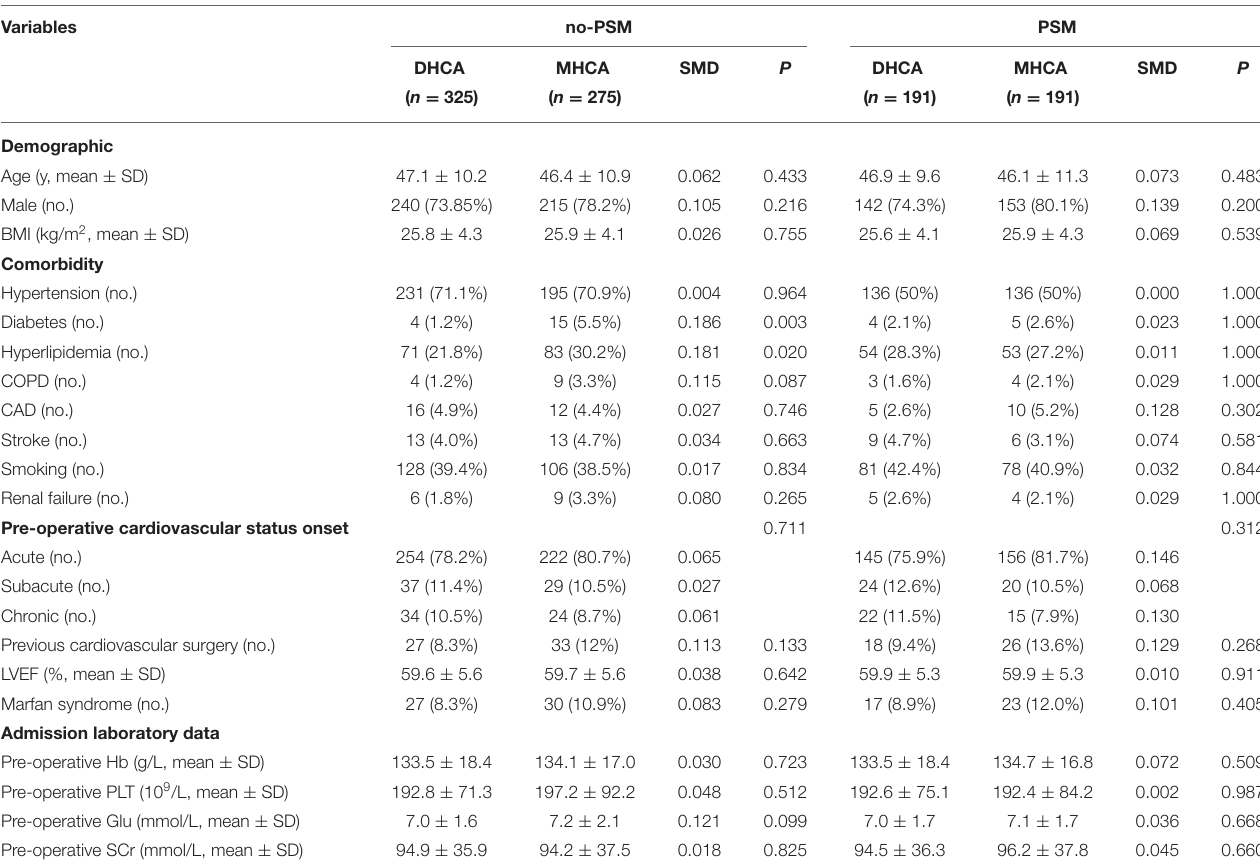
TABLE 1 | Pre-operative characteristics.